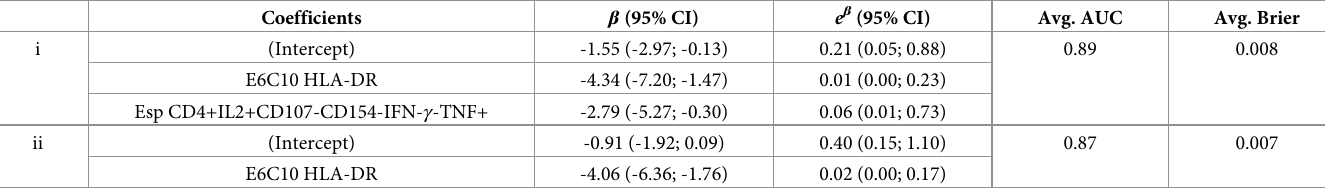
Table 1. Model estimates and the average performance metrics after internal validation of the final LR model (i) and the LR model built to E6C10-specific total Th 1 cells expressing HLA-DR only (ii).